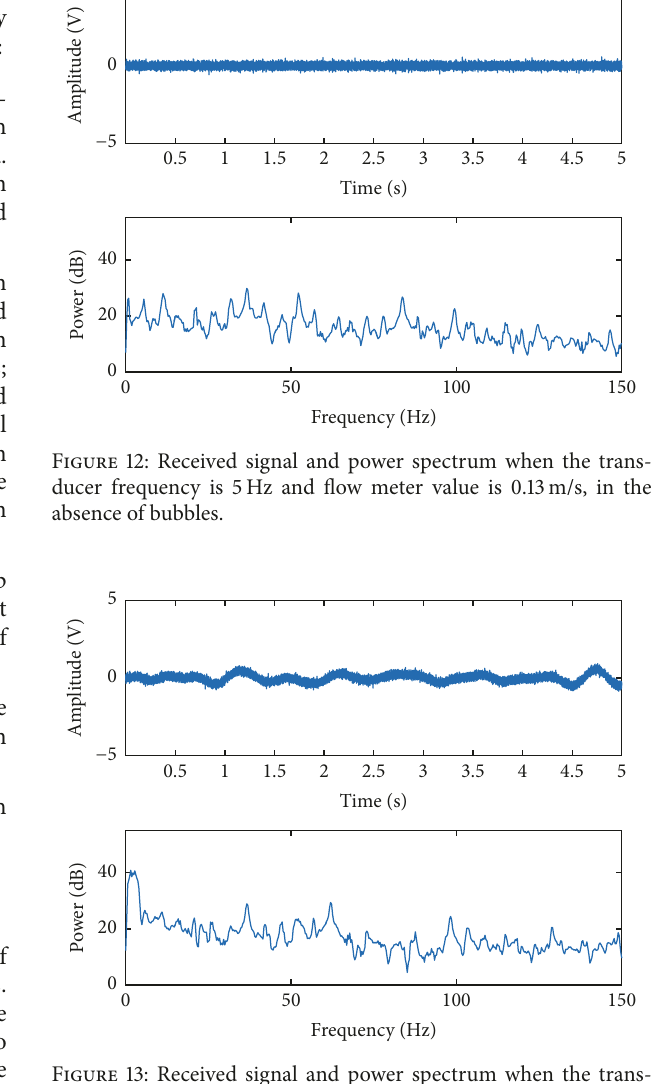
Figure 13: Received signal and power spectrum when the trans- ducer frequency is 5 Hz and flow meter value is 0.15 m/s, in the presence of